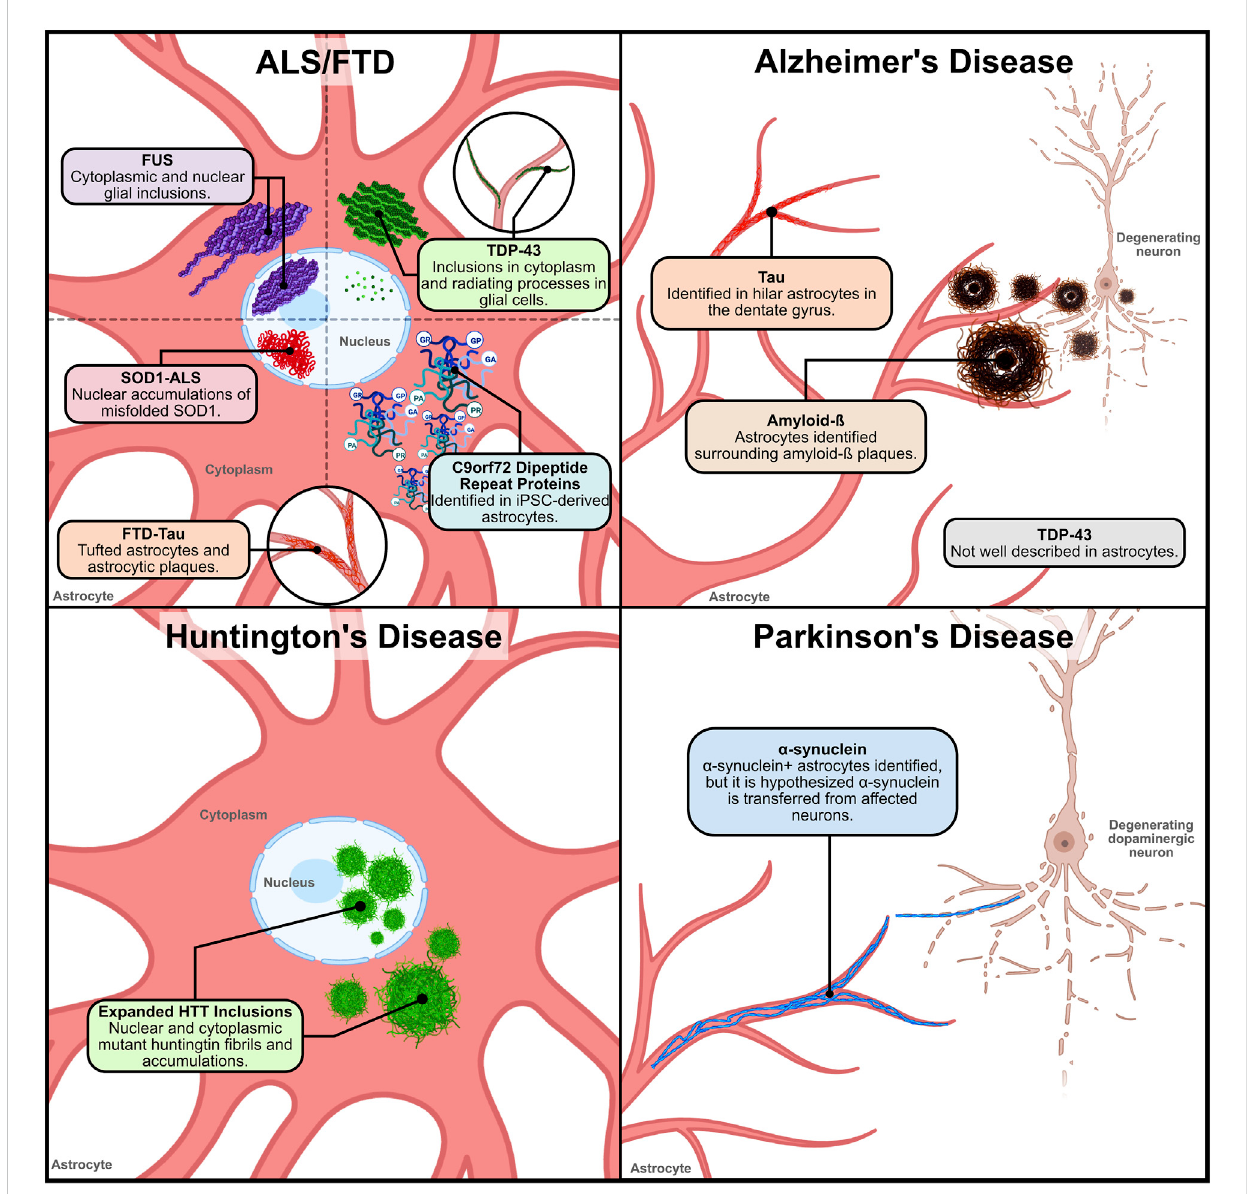
FIGURE 1 Location and distribution of neurodegenerative disease proteinopathies within and around astrocytes. 1) ALS/FTD – Various proteinaceous inclusions occur in ALS and FTD astrocytes. In ALS and FTD, TDP-43 inclusions have been found in the cytoplasm and radiating processes of glial cells. In ALS and FTD cases with FUS variants, cytoplasmic and nuclear glial inclusions have been identi fi ed. However, the identi fi cation of TDP-43 and FUS inclusions speci fi cally in astrocytes has not been clari fi ed. Nuclear accumulations of misfolded SOD1 caused by ALS-linked genetic variants have been identi fi ed in ventral horn astrocytes. In FTD-TAU, tufted astrocytes and astrocytic plaques have been observed in patient tissue. This pathology is similar to what has also been observed in AD tauopathy. and in C9orf72-ALS iPSC-derived spinal cord-like astrocytes the presence of DPRs were detected.2)Alzheimer ’ sdisease – InAlzheimer ’ sdisease,astrocyteshavebeendescribedtosurroundandinternalizeextracellularamyloid-ß(Aß)plaques. Reactive astrocytes found in postmortem AD tissue have been observed to have a signi fi cant Aß load. Tau is not expressed in astrocytes explicitly, so the sourceoftauinastrocyticaccumulationsinADisunknown.However,tauaccumulationinhilarastrocyteshasbeendescribed.ADTDP-43pathologyhas not been well characterized in astrocytes. 3) Huntington ’ s disease – In Huntington ’ s disease, expanded huntingtin (HTT) fi brils in the nucleus and cytoplasm of cortical and striatal astrocytes have been observed. Expanded HTT inclusions in astrocytes occurs early in the disease pathogenesis, suggesting that astrocytic disruptions may contribute to disease progression. 4) Parkinson ’ s disease – In Parkinson ’ s disease, α -synuclein + inclusions in astrocytes of PD patient tissue found within the SN, midbrain, amygdala, thalamus, striatum and cerebral cortex. In early stages of disease pathogenesis, α -synuclein + astrocytesarefoundintheamygdala,striatum,andthalamicnucleiprojectingtothecortex.Inthecortex,astrocytic α -synuclein + inclusions are found in layers V and VI, with limited prevalence in layers III and IV. However, studies hypothesize that the α -synuclein found in astrocytes is possibly transferred from affected dopaminergic neurons. Figure created with